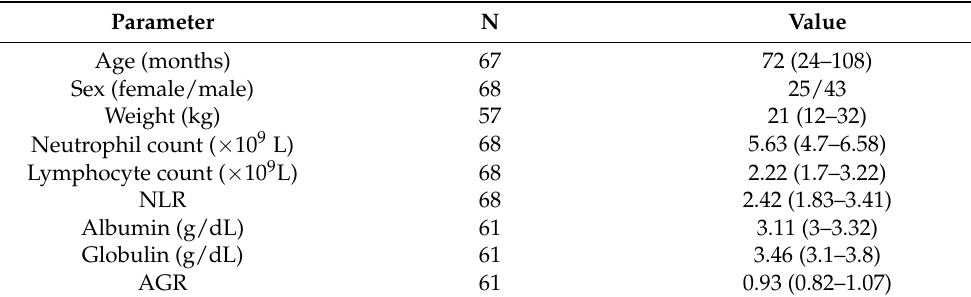
Table 1. Selected clinicopathological characteristics of healthy